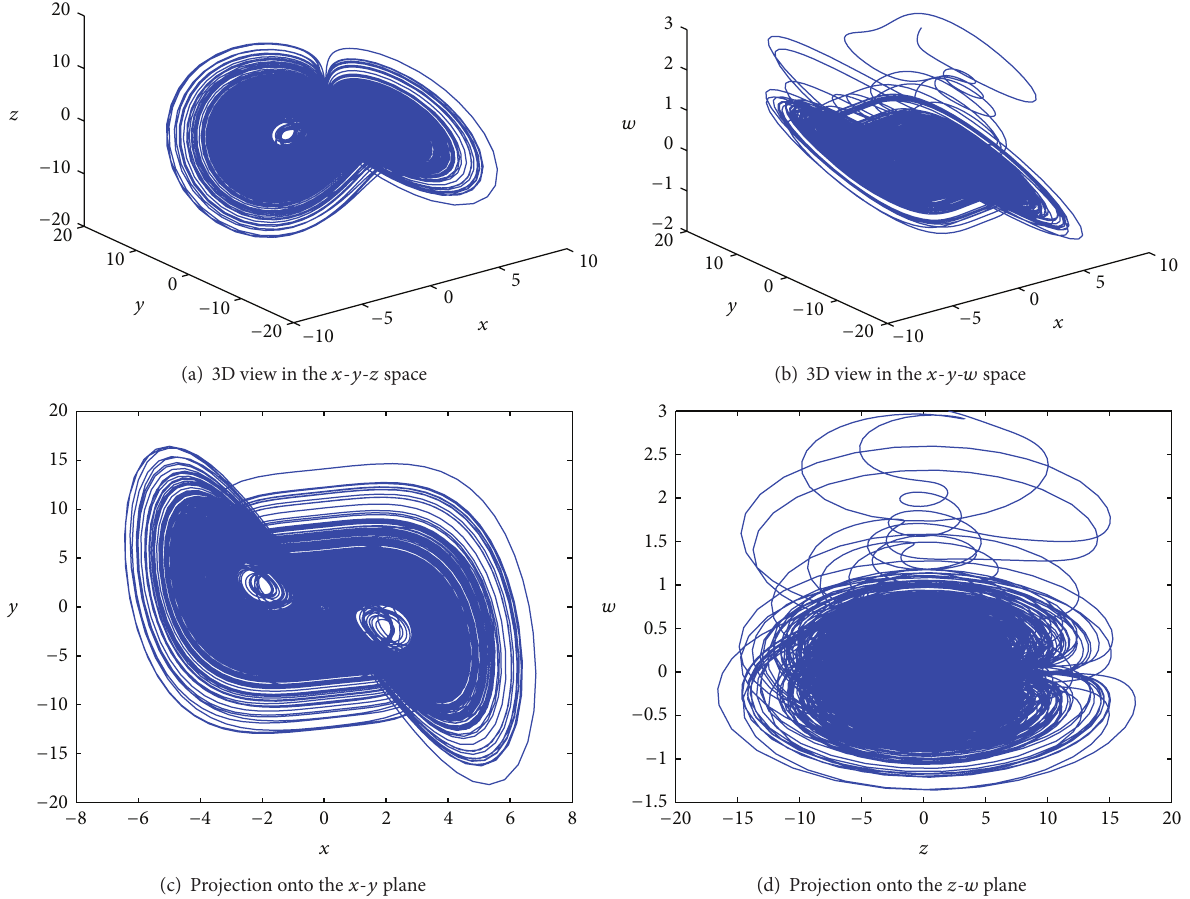
Figure 3: Phase portraits of hyperchaotic finance system